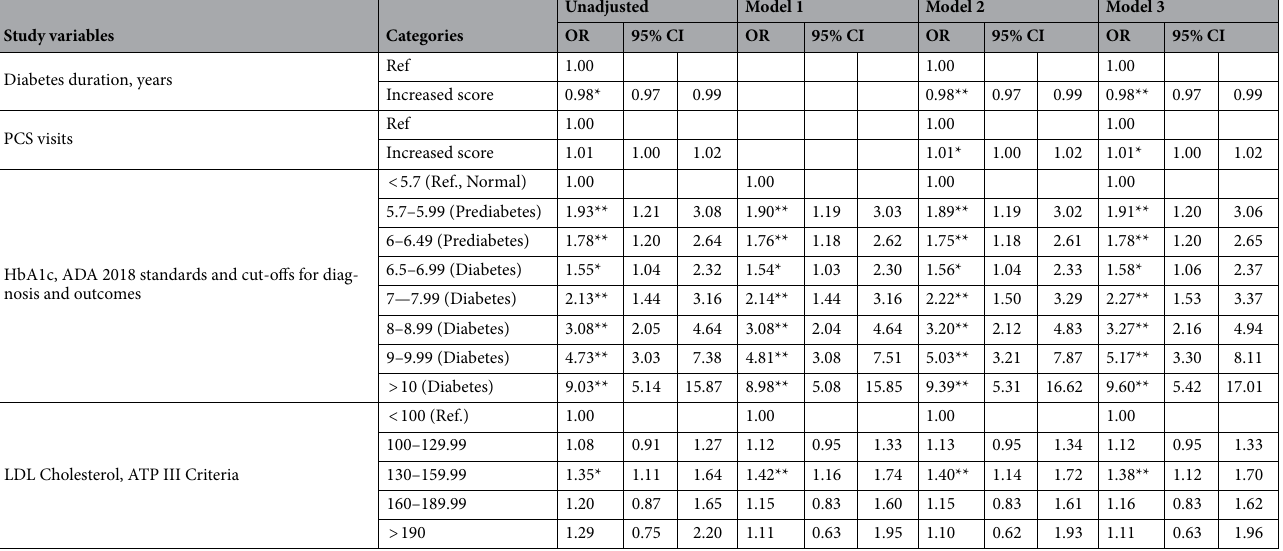
Table 3. Risk estimation for treatment nonadherence of primary DM outcomes by cut-off standards through hierarchical multivariate logistic regression models on diabetic patients with comorbid depression (N = 3340). Model 1 = Adjusted by age, gender, and primary DM outcomes: HbA1c, ADA criteria; and LDL Cholesterol, ATP III criteria. Model 2 = Model 1 + T2D duration (years), depression duration (years), nurse and PCS visits, and smoking status. Model 3 = Model 2 + : # drug intake, BMI, systolic blood pressure, diastolic blood pressure. Only variables with significant results are displayed in this table. * p < .05; ** p < .01.